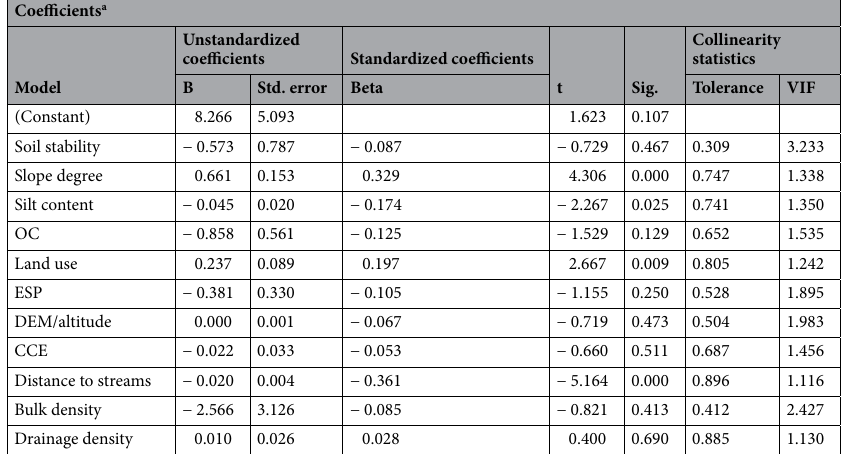
Table 2. Multicollinearity analysis for gully heads in 2021. CCE,calcium carbonate equivalent; OC, organic carbon; ESP, exchangeable sodium percentage. a Dependent variable: Gully heads 2021.